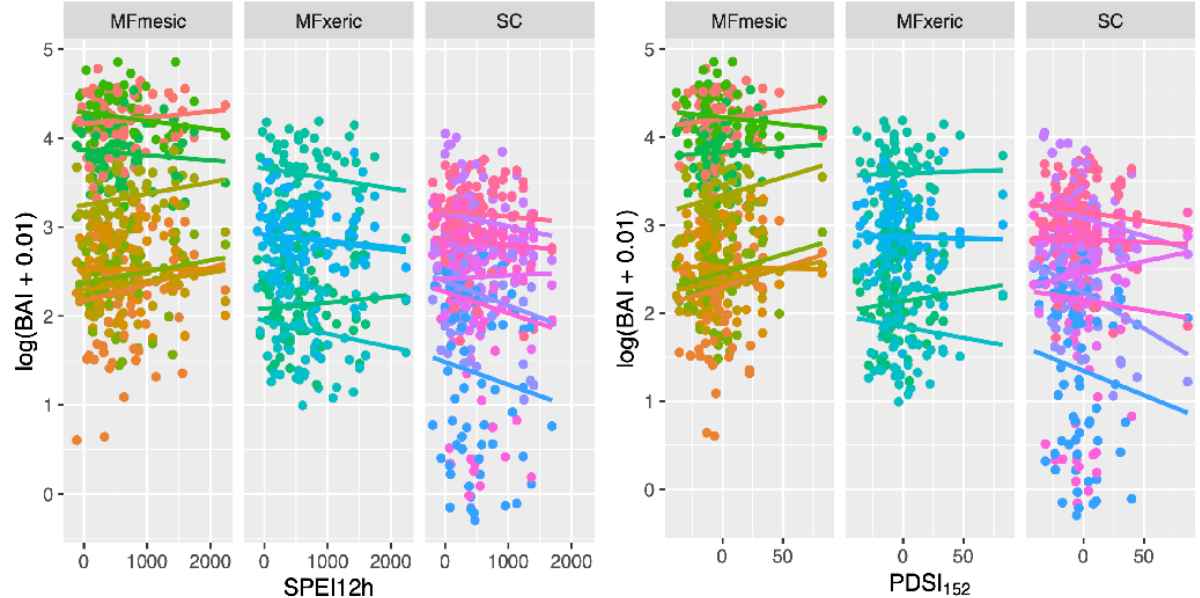
Figure 6. Log(BAI + 0.01) at the two MF subsites and SC showing different responses to SPEI ( left )